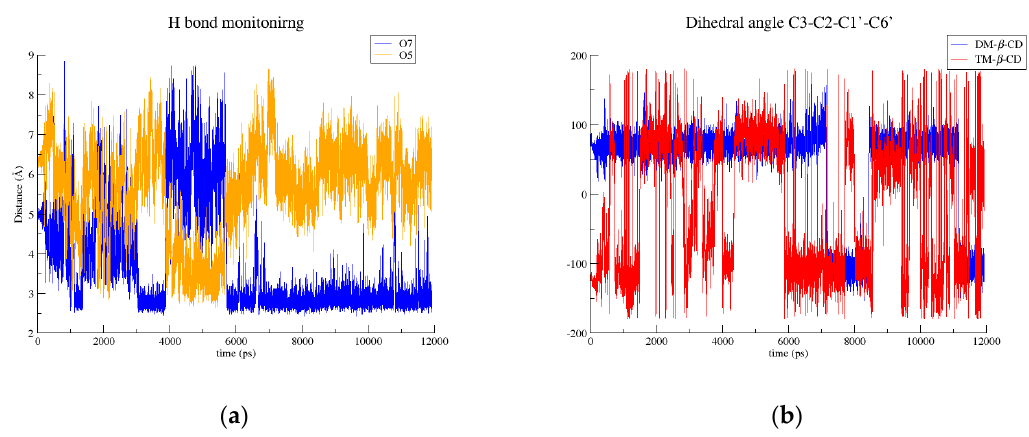
Figure 6. ( a ) H-bond monitoring between the hydroxyls of the ring A of the chromone group (atoms O7 and O5) of the guest molecule and the secondary methoxy group of the third glucose unit of TM- β - CD and ( b ) dihedral angle C3-C2-C1’-C6’ of naringenin in both